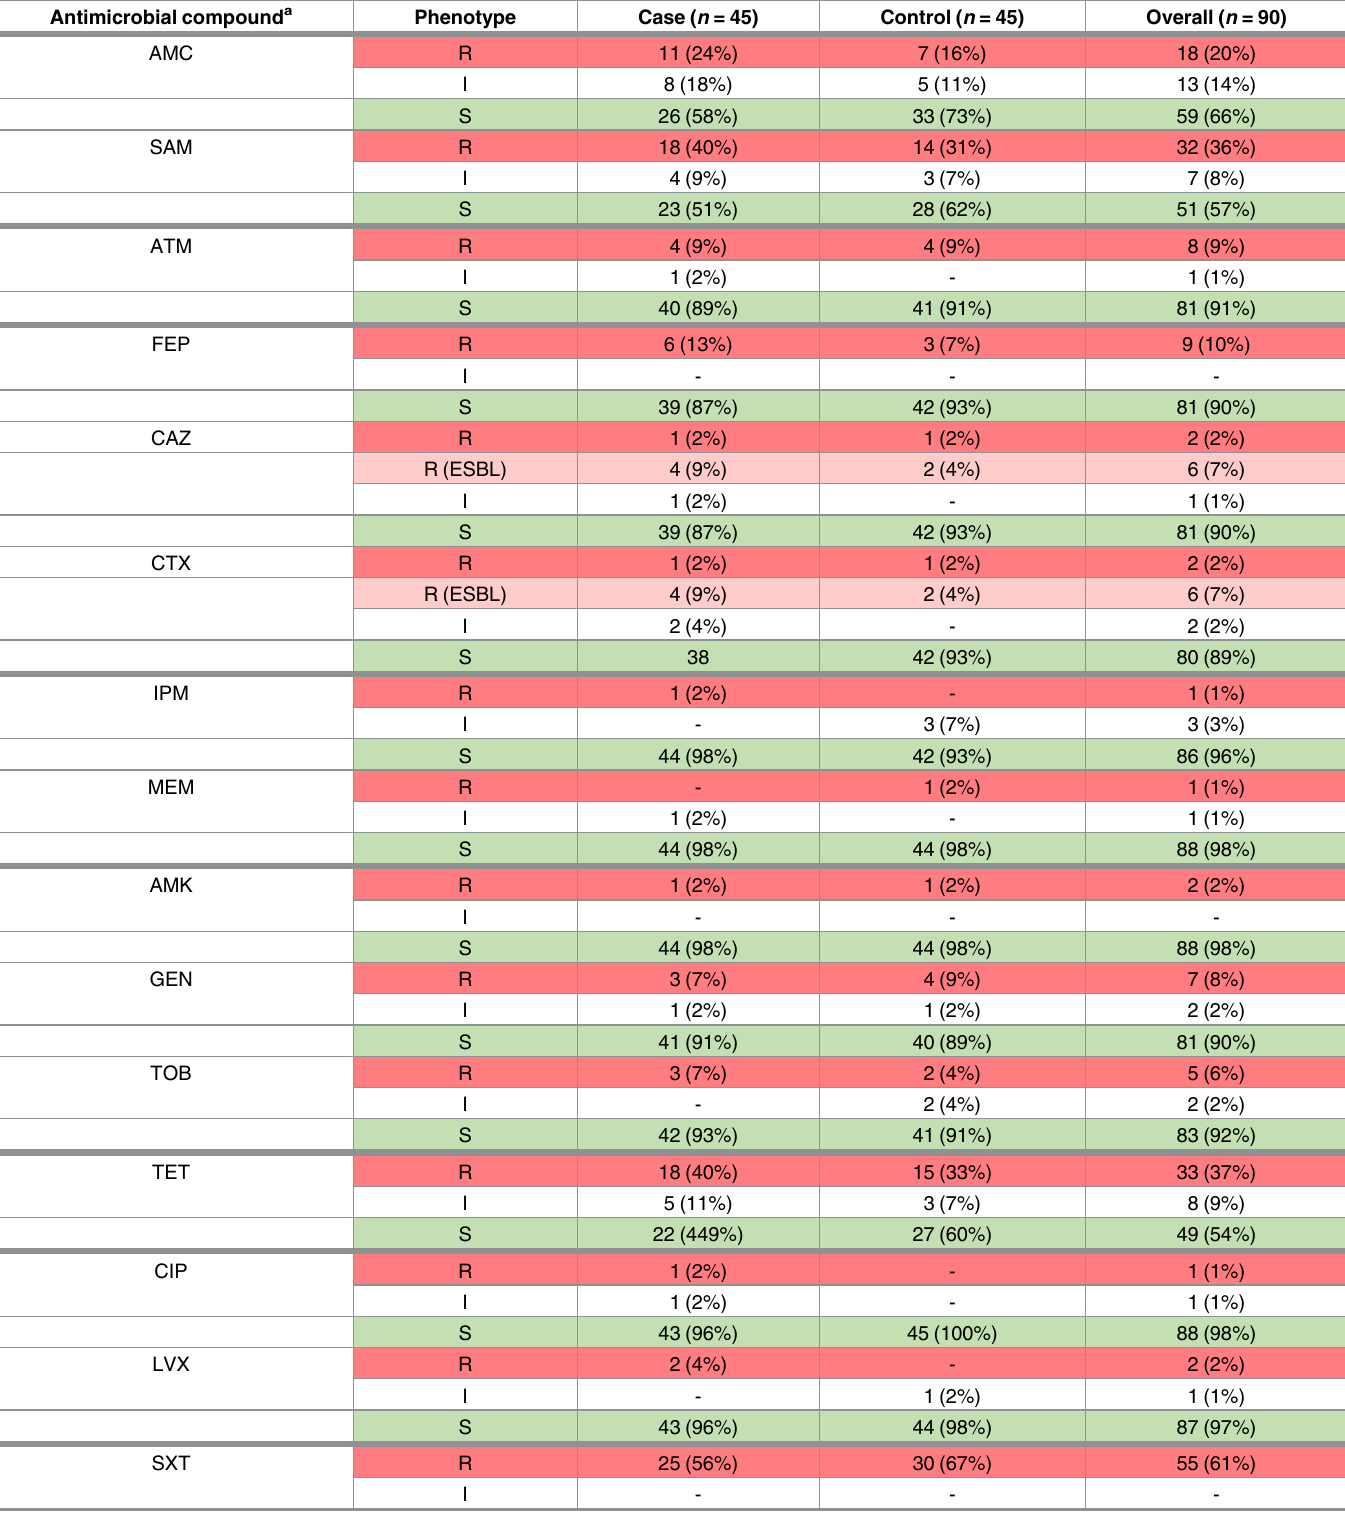
Table 1. Summaryof antimicrobial phenotypic susceptibility for diarrheal and control isolates. Antimicrobial compound